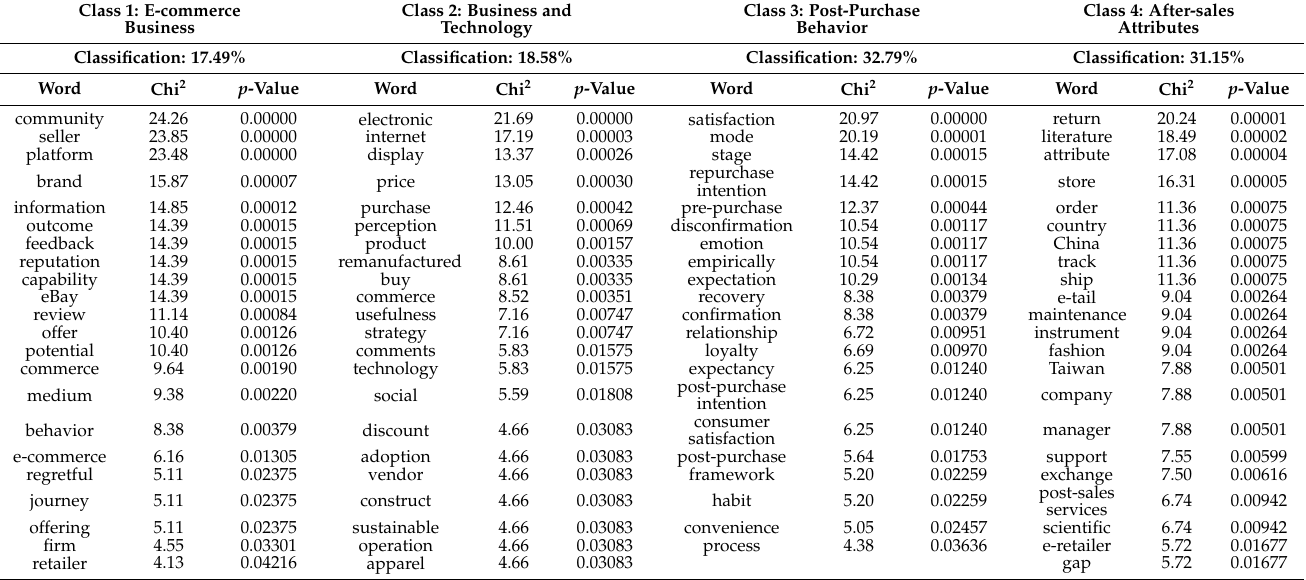
Table 2. Typology analysis of the textual